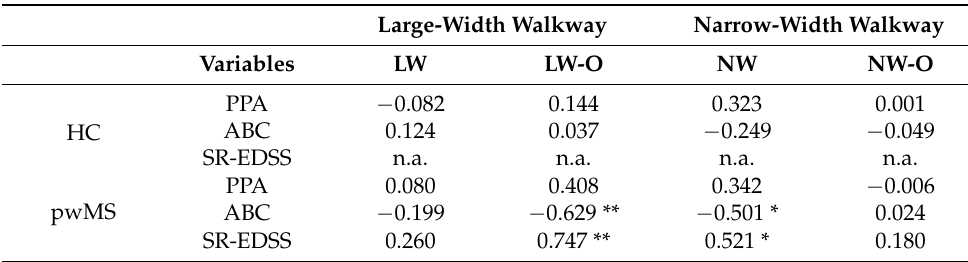
Table 4. Spearman’s Rho Correlations between A-MC and measures of physiological fall-risk and balance